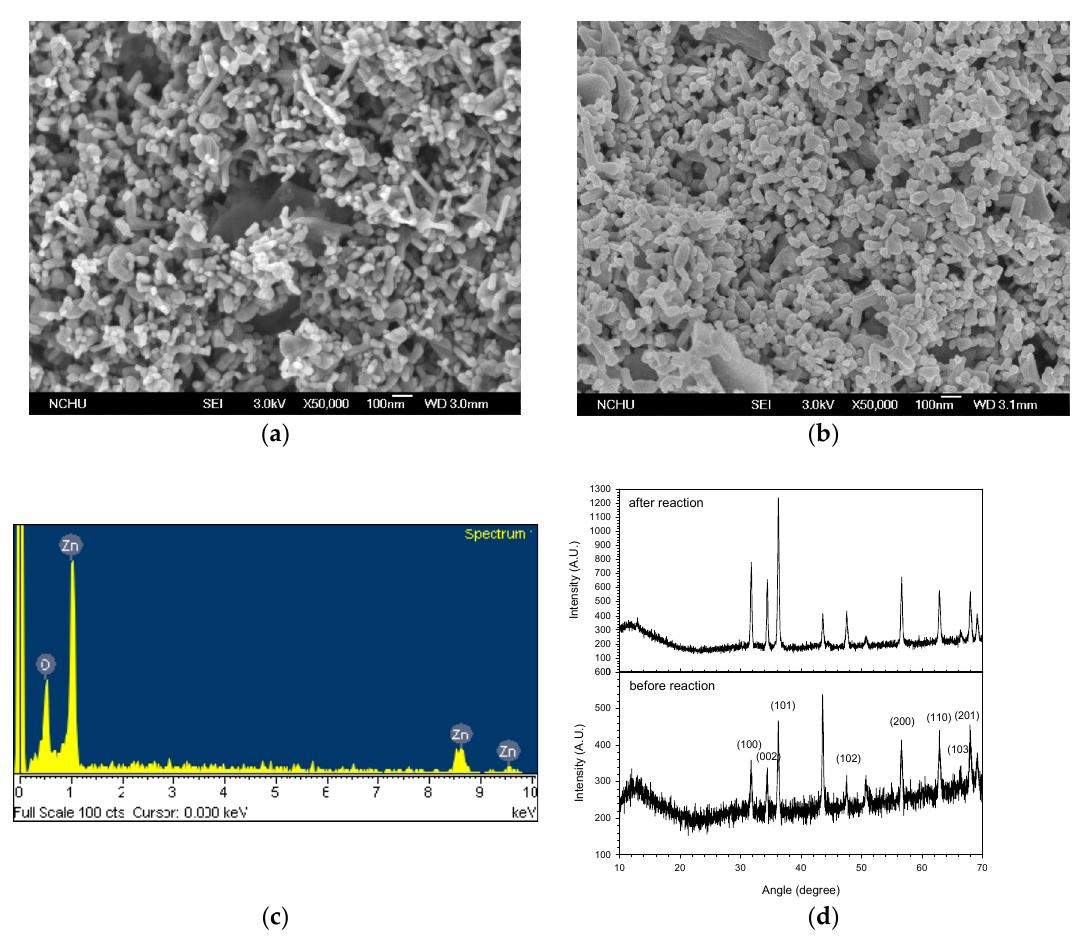
Figure 1. The FESEM images of immobilized ZnO on the steel mesh ( a ) before and ( b ) after the photocatalytic reaction. The ( c ) EDS spectrum and ( d ) XRF spectra before and after the photocatalytic reaction.